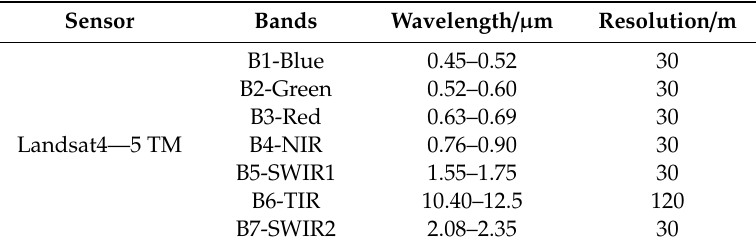
Table 1. Parameters of Landsat4—5 thematic mapper (TM).